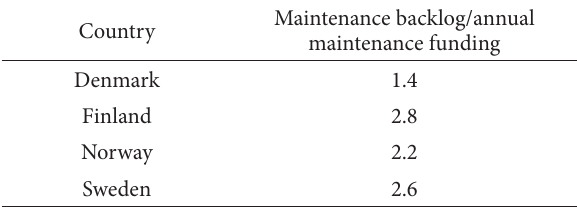
Table 3. Maintenance backlog in Nordic countries in relation to